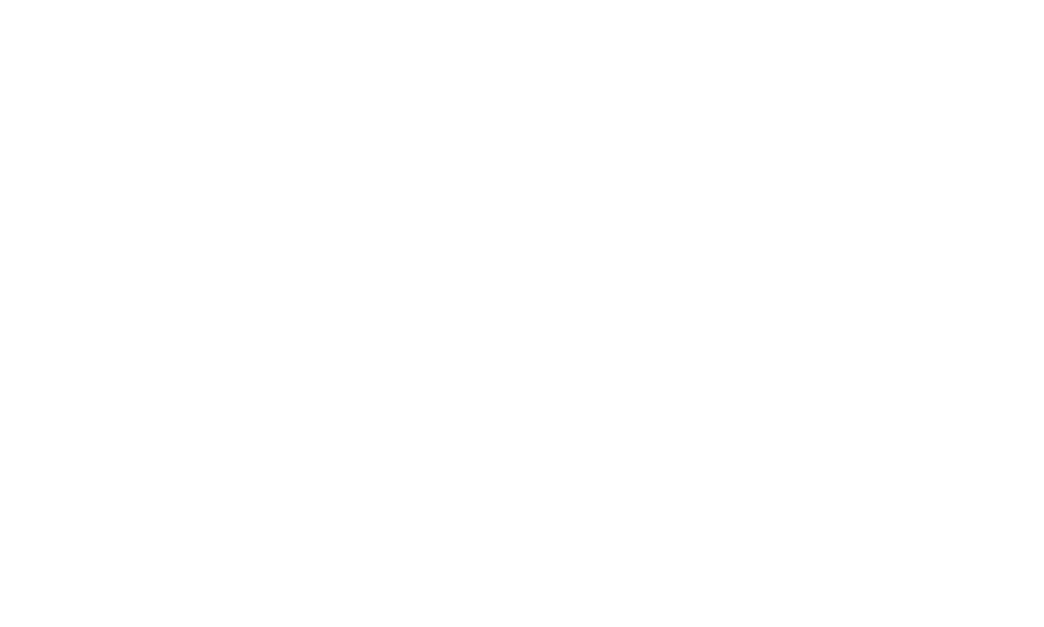
Figure 9. Comparison between the numerical and predicted values of ( a ) simulation